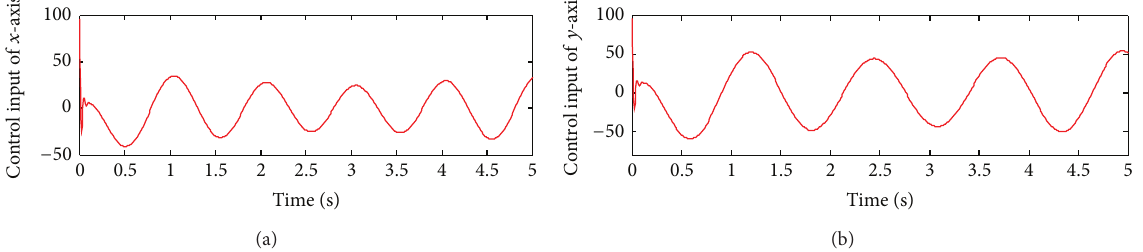
Figure 7: Control inputs for gyroscope with adaptive neural sliding compensator ((a): 𝑢 𝑥 ; (b): 𝑢 𝑦 ).